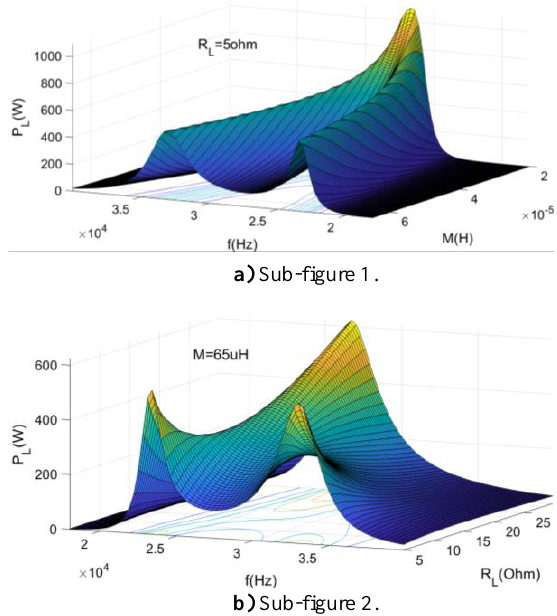
Figure 2. Output power’s (PL’s) variation as a function of f –M (a) , and f –RL